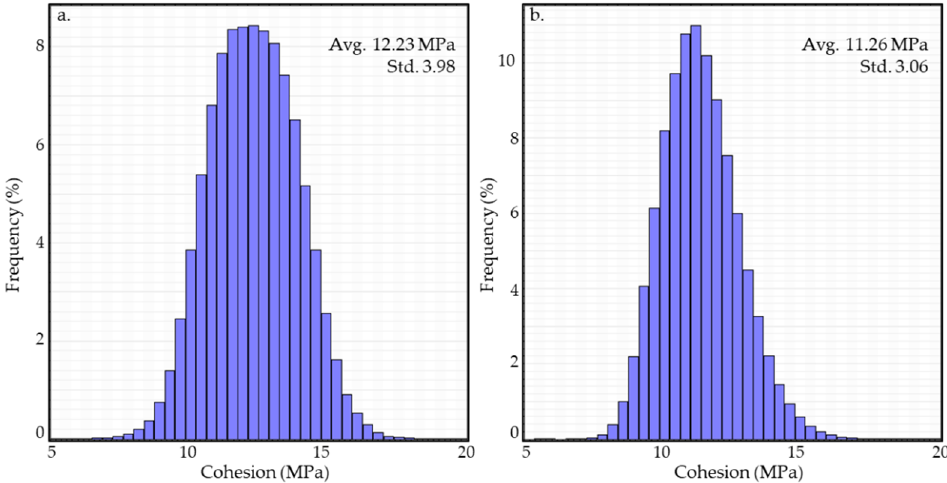
Figure 4. Seismic inverted cohesion property distribution in upper Drake unit ( a ) and lower Drake unit ( b ). The average and standard deviation estimated from these distributions are used as the input parameters for the model.